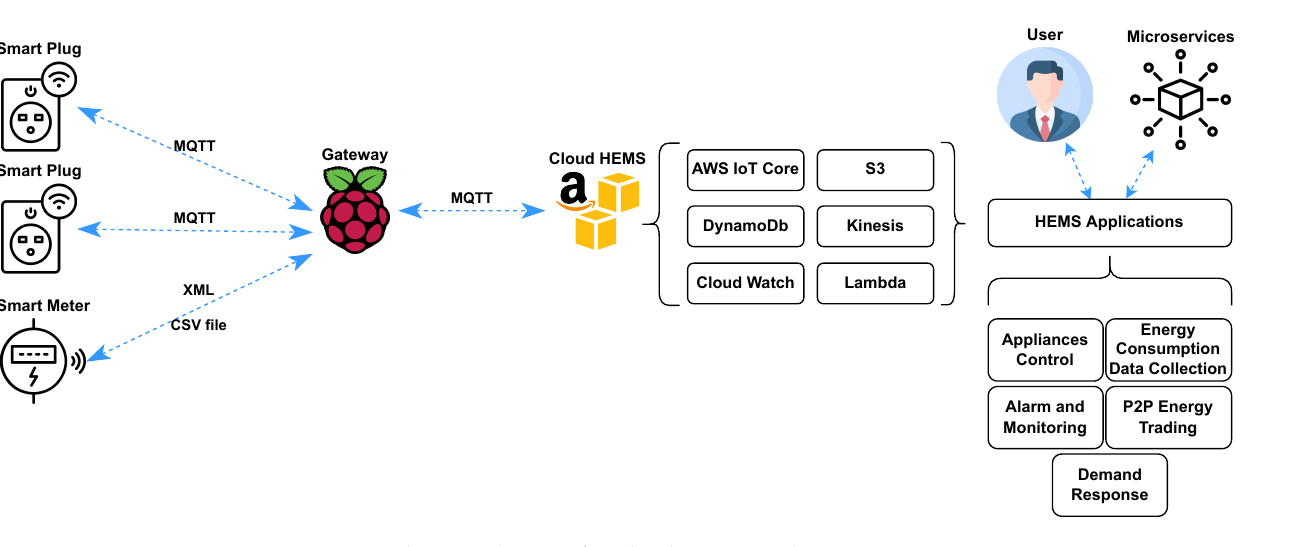
Figure 6. Schematic diagram for Cloud HEMS